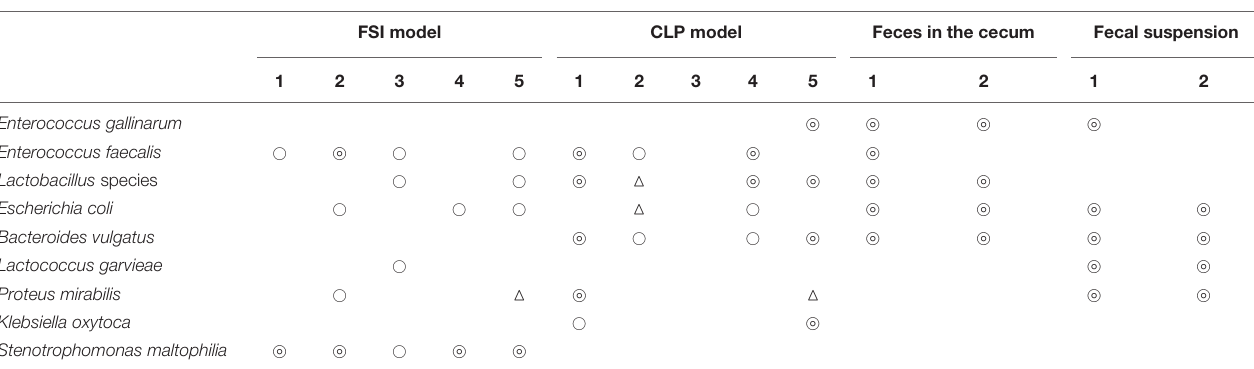
TABLE 1 | Results of bacterial species identification in ascites